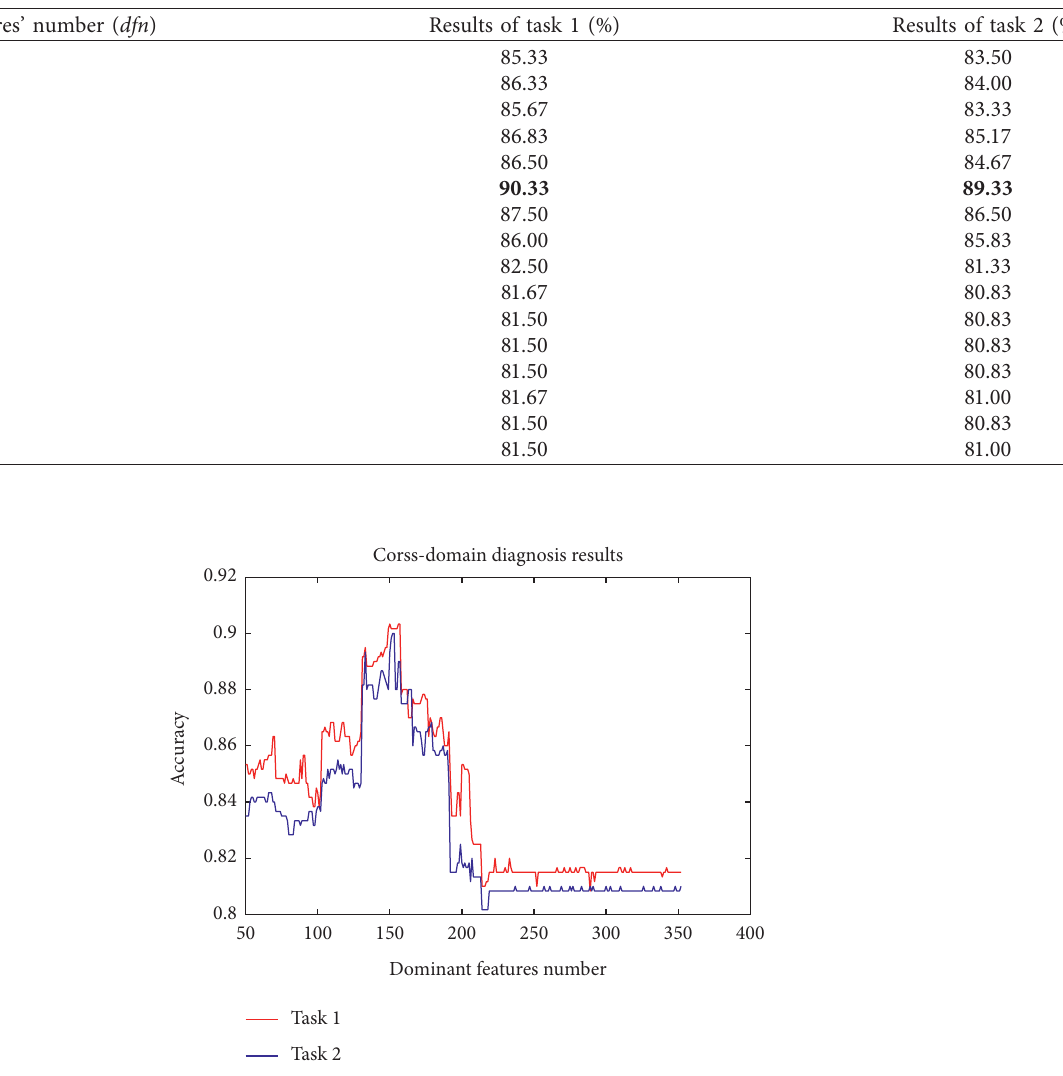
Figure 17: The diagram of cross-domain fault diagnosis results of TFDD framework.